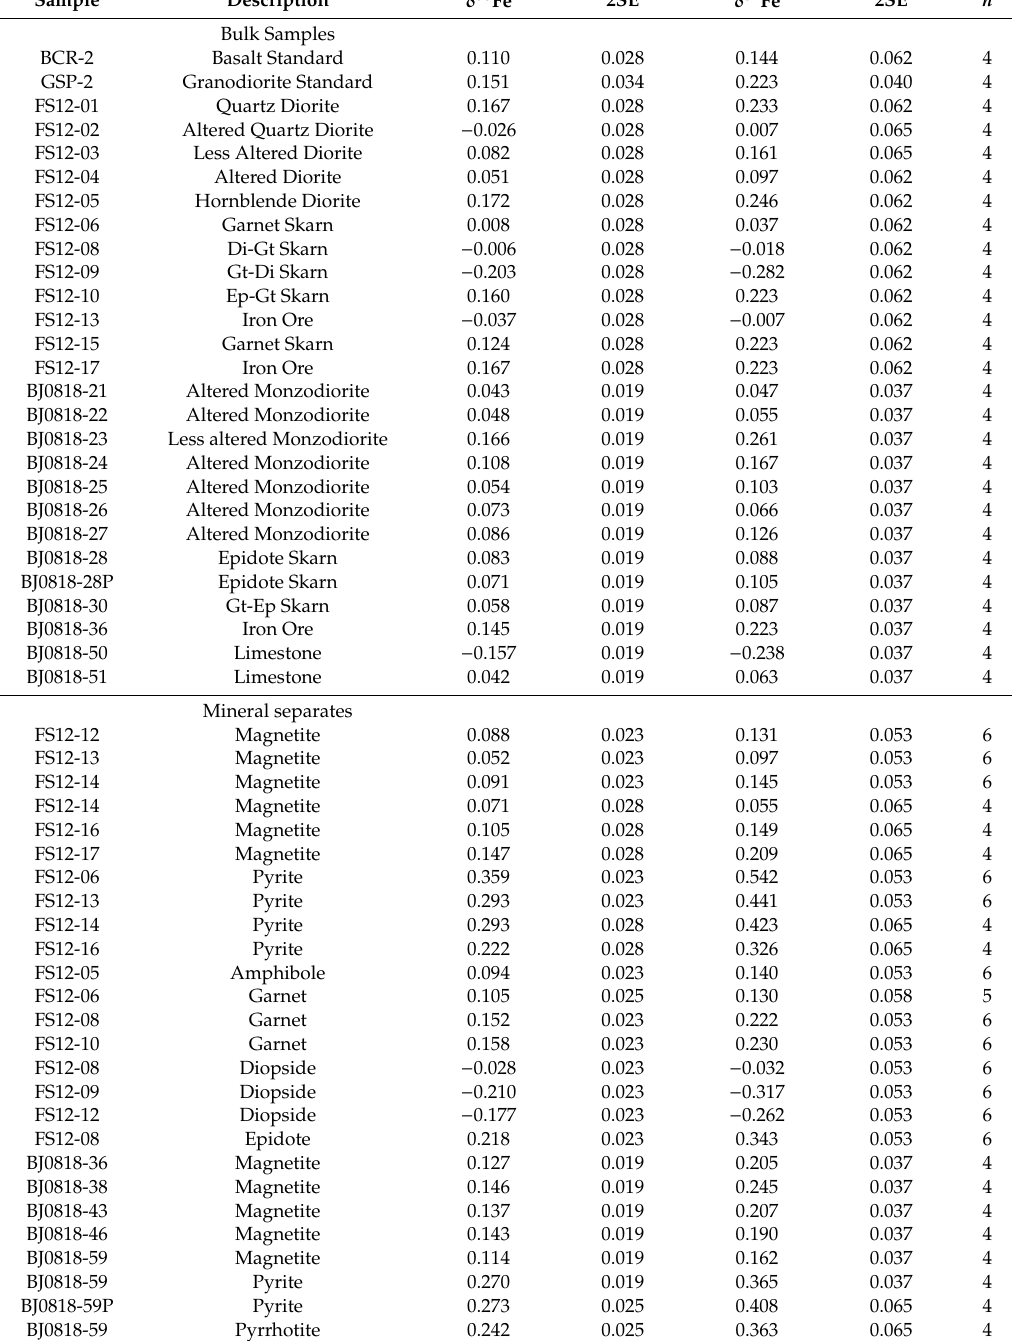
Table 3. Fe isotope composition of whole rocks and mineral separates from the Han-Xing iron skarn